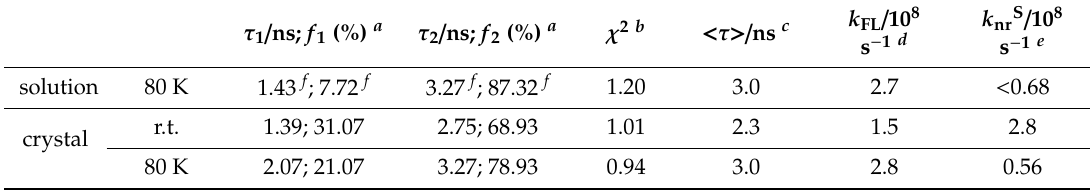
Table 3. Photoluminescence lifetimes and kinetic constants of LAlH .